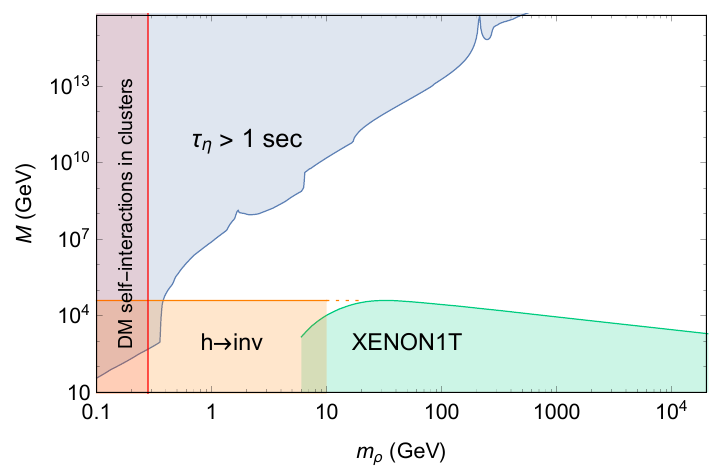
Figure 6 . Experimental and astrophysical constraints on our model, as a function of DM mass m (cid:26) and the scale M governing interactions between DM and the Higgs (cid:12)eld. Shaded regions are excluded. This plot assumes (cid:30) = (cid:25)= 4 and m q = (cid:3) = 0 : MS